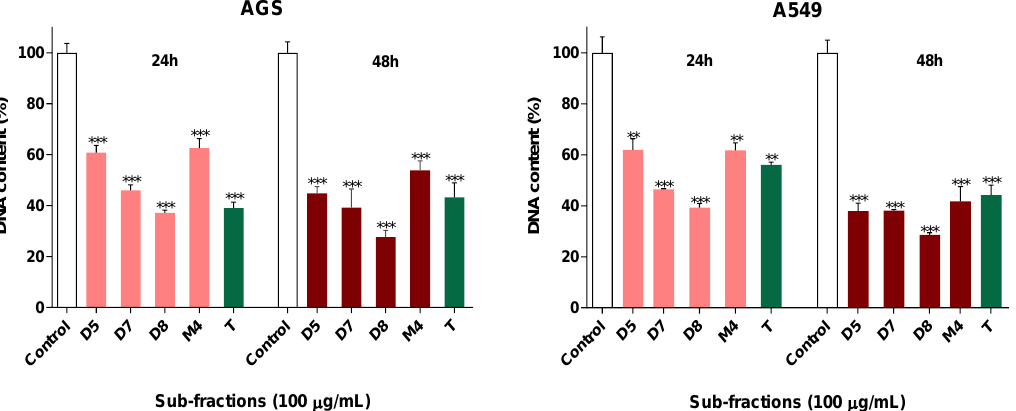
Figure 4. DNA content of AGS and A549 cells treated with sub-fractions (100 µg/mL) for 24 h and 48 h. Data represent the mean ± SD of at least three independent experiments performed in triplicate., ** p < 0.01, *** p < 0.001.